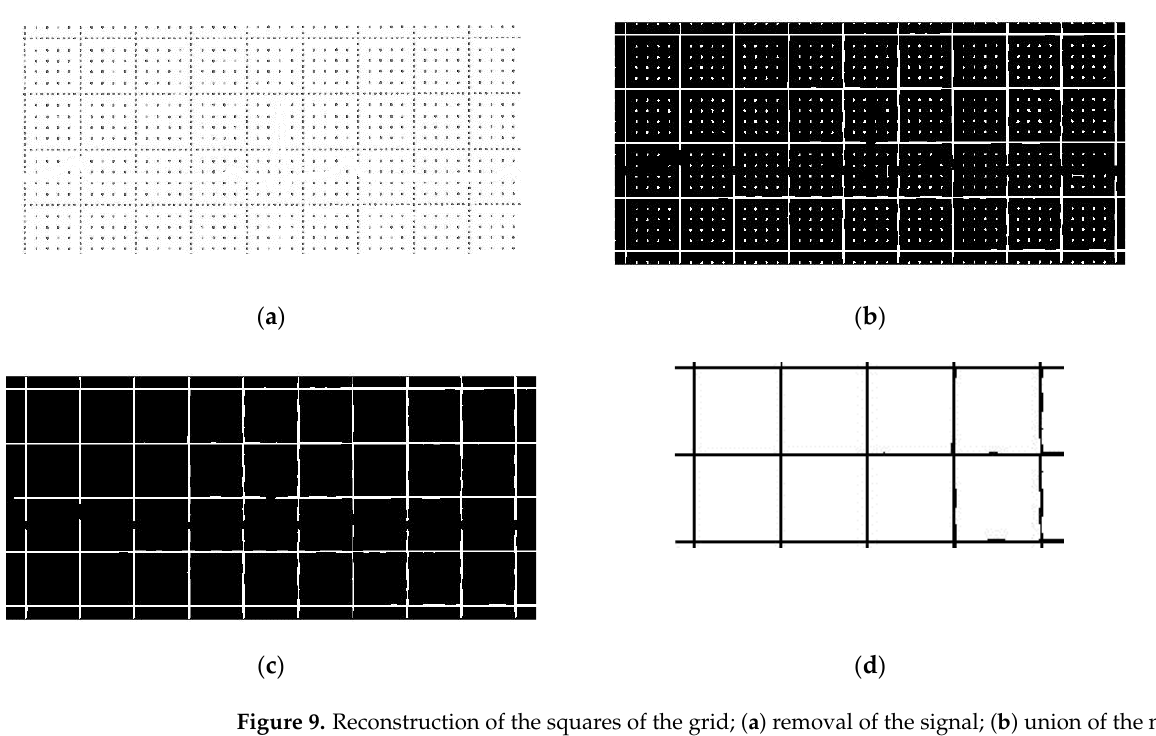
Figure 9. Reconstruction of the squares of the grid; ( a ) removal of the signal; ( b ) union of the nearest points; ( c ) removal of the furthest points; and ( d ) final squares with 5 mm sides.